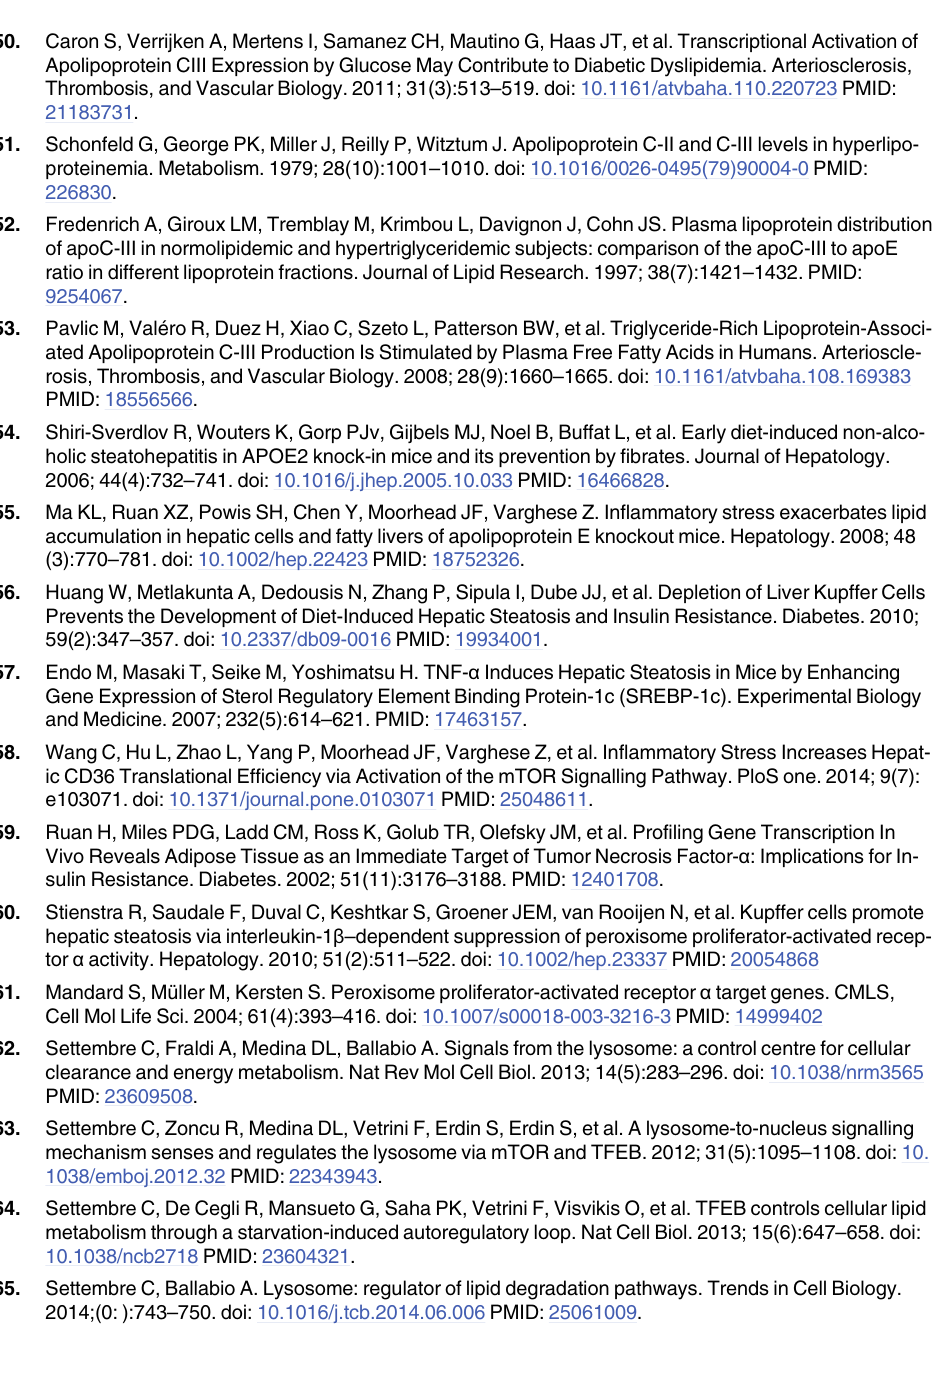
PLOS ONE | DOI:10.1371/journal.pone.0129402 June 5,